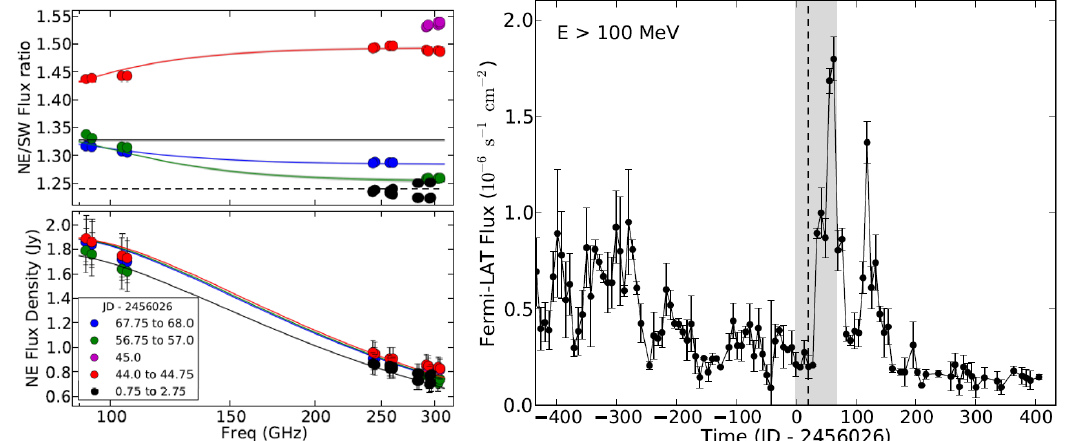
Figure 3. Top left : Image contrast (i.e., intensity ratio) between the two lensed images of the blazar in PKS1830 − 211. Bottom left : Total intensity of the North-East (NE) lensed image. Notice the clear frequency dependence of the contrast at each epoch (related to the synchrotron opacity at the jet base) and the fast variability (intra-hour) around days 44.75 − 45 (magenta). The lines correspond to a jet model fitted to the data [10]. Right : γ -ray light curve from the Fermi-Large Area Telescope (LAT), with a time binning of 7 days. The shadowed region is the time window of our ALMA observations. The dashed line is the onset of the flare, as estimated from our model to the ALMA data. Figures adapted from [10] and reproduced with permission from A&A,